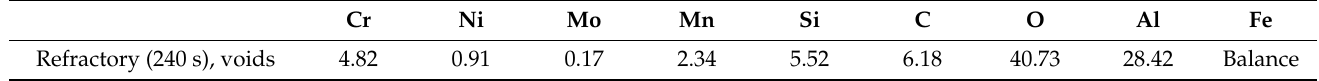
Table 5. Wt. % of the chemical composition within the pores of refractory ballast sintered. Cr Ni Mo Mn Si C O Al